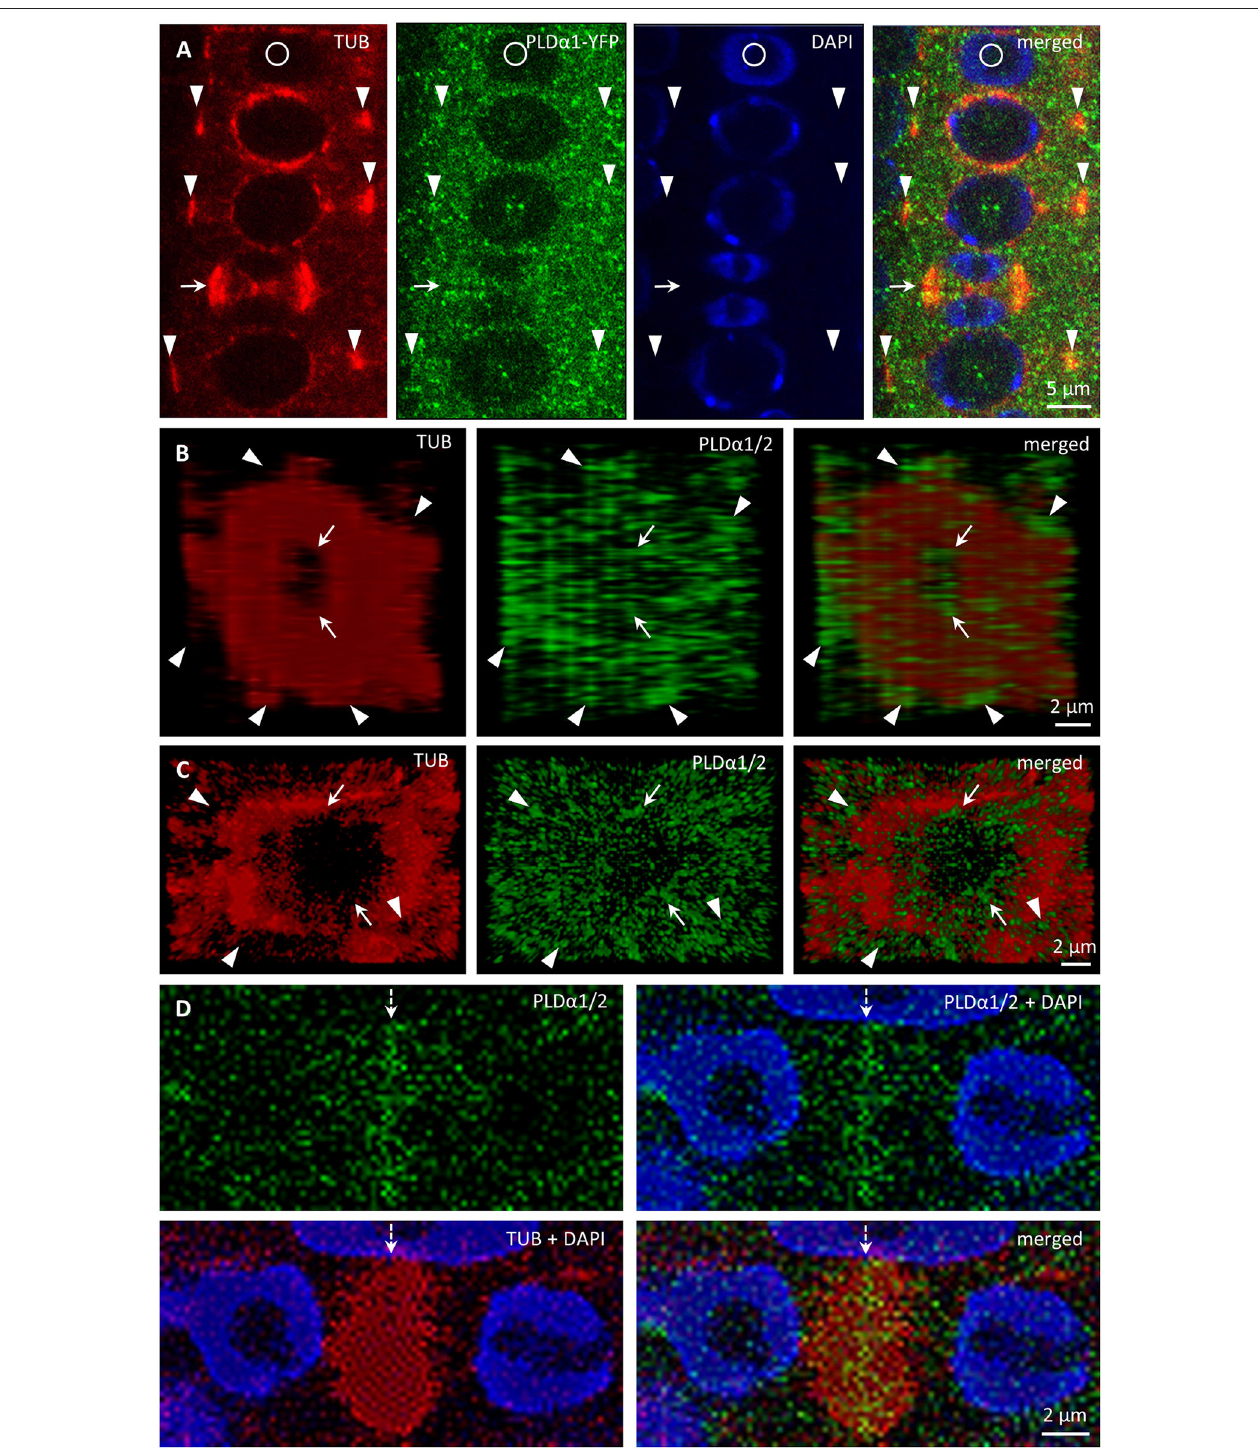
FIGURE 10 | Immunofluorescence colocalization of microtubules and PLD α 1–YFP during cell division in Arabidopsis root meristem cells of complemented pld α 1-1 mutant seedlings expressing PLD α 1-YFP. (A) Colocalization of PLD α 1-YFP with microtubules of PPB (arrowheads) and late phragmoplast (arrow). Note that circle indicates non-dividing cell. (B) Orthogonal projection of disk phragmoplast stage with the distribution of PLD α 1-YFP at the leading (outer) edge (arrowheads) as well as at the trailing (inner) edge in the central part (arrows) of the phragmoplast. Still image of the orthogonal projection corresponds to Video S3 . (C) Orthogonal projection of more advanced ring phragmoplast showing association of PLD α 1-YFP with the leading edge (arrowheads) and the trailing edge (arrows) of the phragmoplast. Still image of the orthogonal projection corresponds to Video S4 . (D) Accumulation of PLD α 1-YFP in central part of the phragmoplast (arrow) at later stages of cytokinesis.